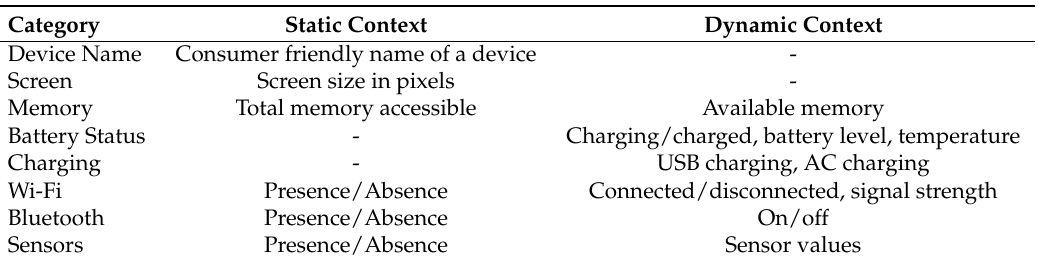
Table 1. A suite of on-device static and dynamic context sensing for the device